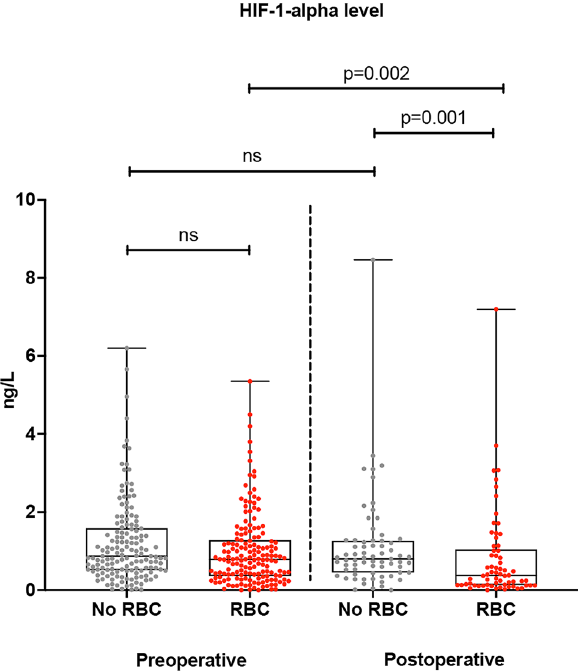
Figure 3. Pre- and postoperative hypoxia-inducible factor 1 alpha (HIF-1-α) levels (ng/L) in patients with or without red blood cell transfusion (RBC) after adult cardiac surgery. The vertical axis represents HIF-1α cytokine levels (ng/L). The horizontal axis represents patients who received or not RBC transfusion preoperatively and